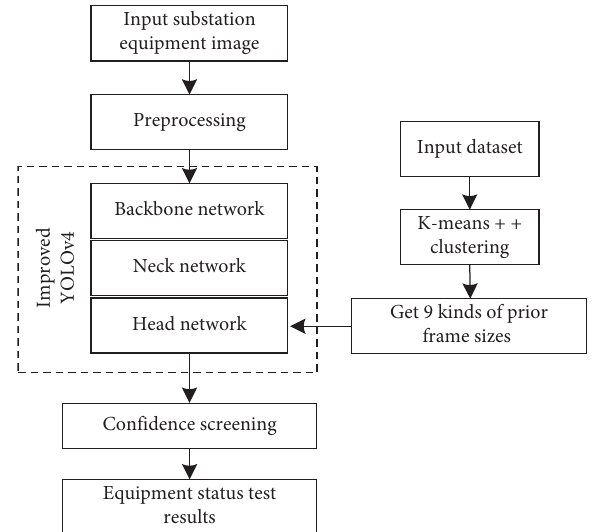
Figure 2: Overall fow of substation equipment state detection model based on improved YOLOv4